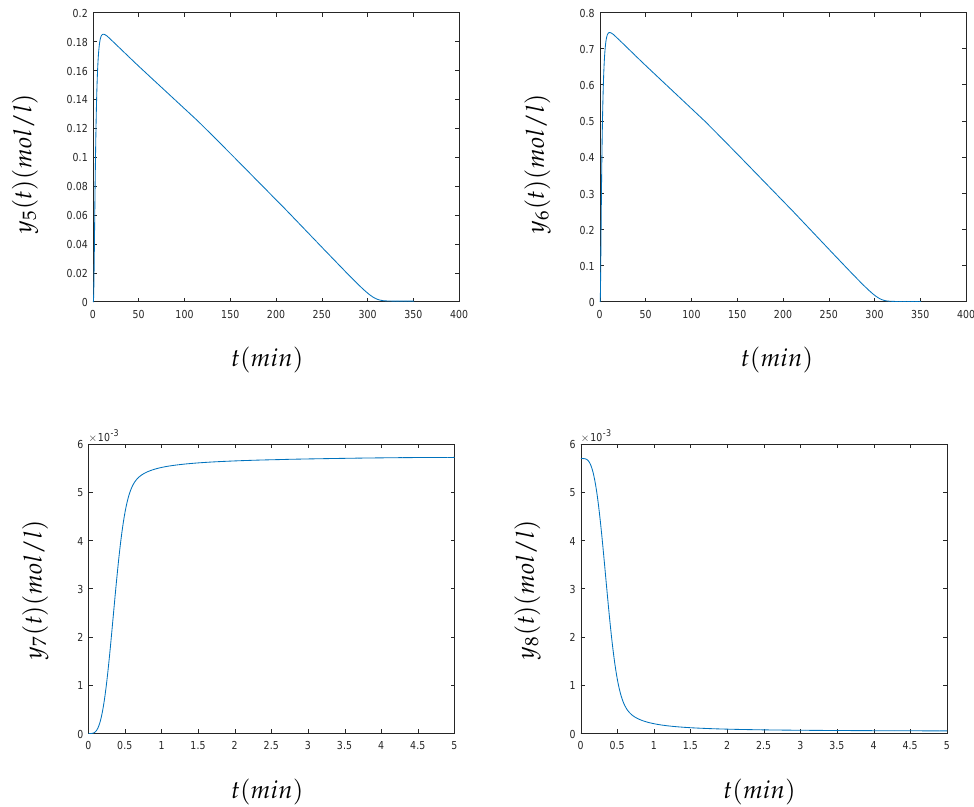
Figure 5. From left to right and top to bottom , we present the numerical solution of the HIRES problem for t ∈ [ 0,5 ] min for the concentrations y 1 , y 2 , y 3 , y 4 , y 7 , y 8 and for t ∈ [ 0,350 ] min for y 5 and y 6